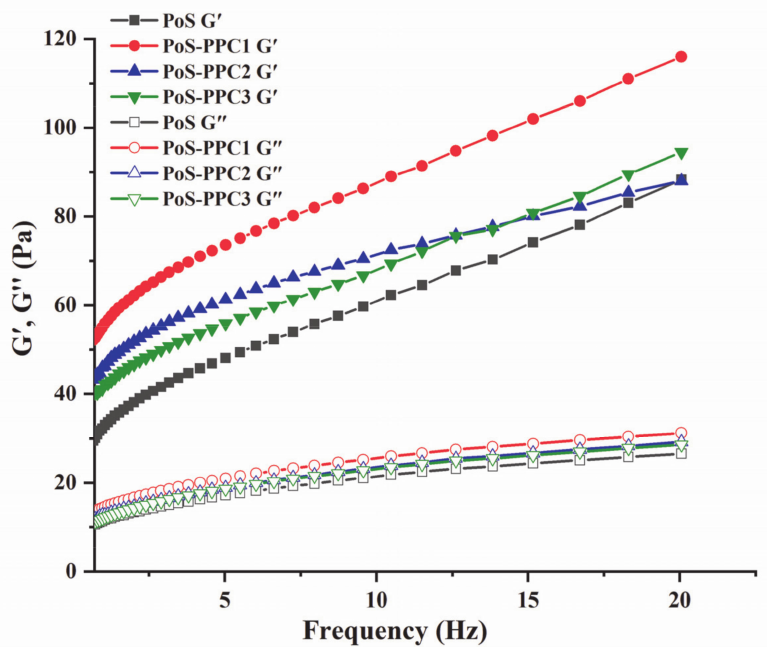
Figure 3. Variation tendency of storage modulus ( G (cid:48) ) and loss modulus ( G (cid:48)(cid:48) ) with frequency for PoS and PoS-PPC mixtures. PoS: potato starch; PPC: polymeric proanthocyanidin.